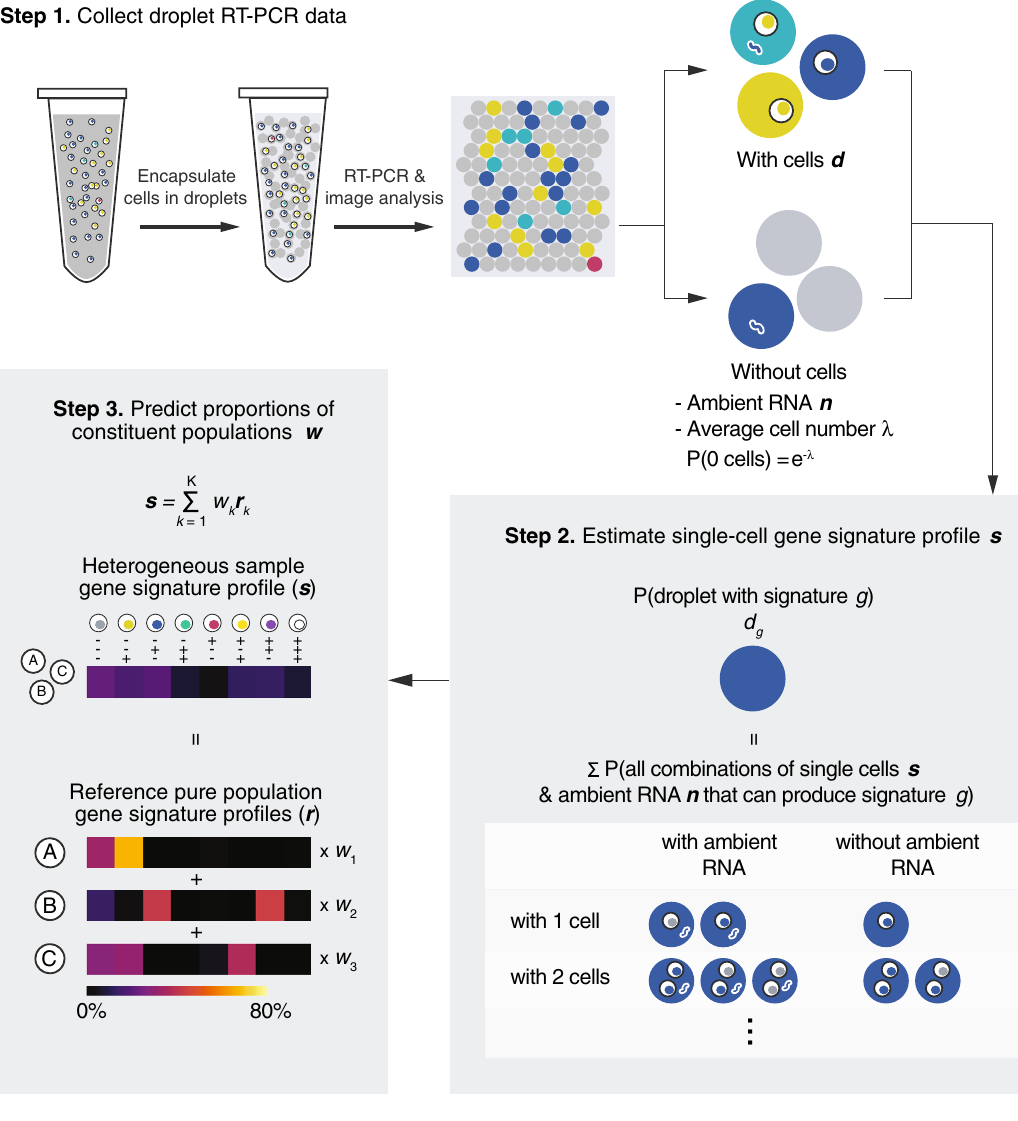
Figure 4. Schematic of deconvolution model to predict single-cell gene signature profiles and the cellular composition of heterogeneous samples. Step 1: Cells are encapsulated and assayed using the droplet RT-PCR platform. The fluorescent signal in every droplet is quantified and the droplet is classified as positive or negative for the presence of cells as well as each target gene. The proportions of droplets that contain cells displaying each gene signature ( d ) are determined. Droplets without cells (empty droplets) inform the probability of observing a certain gene signature in a droplet caused by ambient RNA ( n ). The average number of cells each droplet contains ( λ ) is estimated based on Poisson statistics and the proportions of empty droplets. Step 2: Single-cell gene signature profile of the sample ( s ) is estimated by correcting for ambient RNA and cell doublet effects. Due to the presence of ambient RNA and droplets that contain more than 1 cells, the droplet profile d does not represent the single-cell gene signature profile of the sample. Considering all the combinations of ambient RNA and cells that can generate a certain signature (up to having 2 cells in each droplet), the proportion of cells expressing each gene signature ( s ) is computed based on the data collected in Step 1. Step 3: The proportions of constituent populations in the heterogeneous sample ( w ) is predicted using the sample ( s ) and reference ( r ) gene signature profiles. Given that the heterogeneous sample is a physical mixture of its constituent cell populations with reference gene signature profiles ( r ) (obtained by assaying pure populations), the composition of the sample mixture ( w ) can be predicted based on the non-negative least squares model using the mixed profile ( s ) obtained from Step 2 and the reference profiles ( r